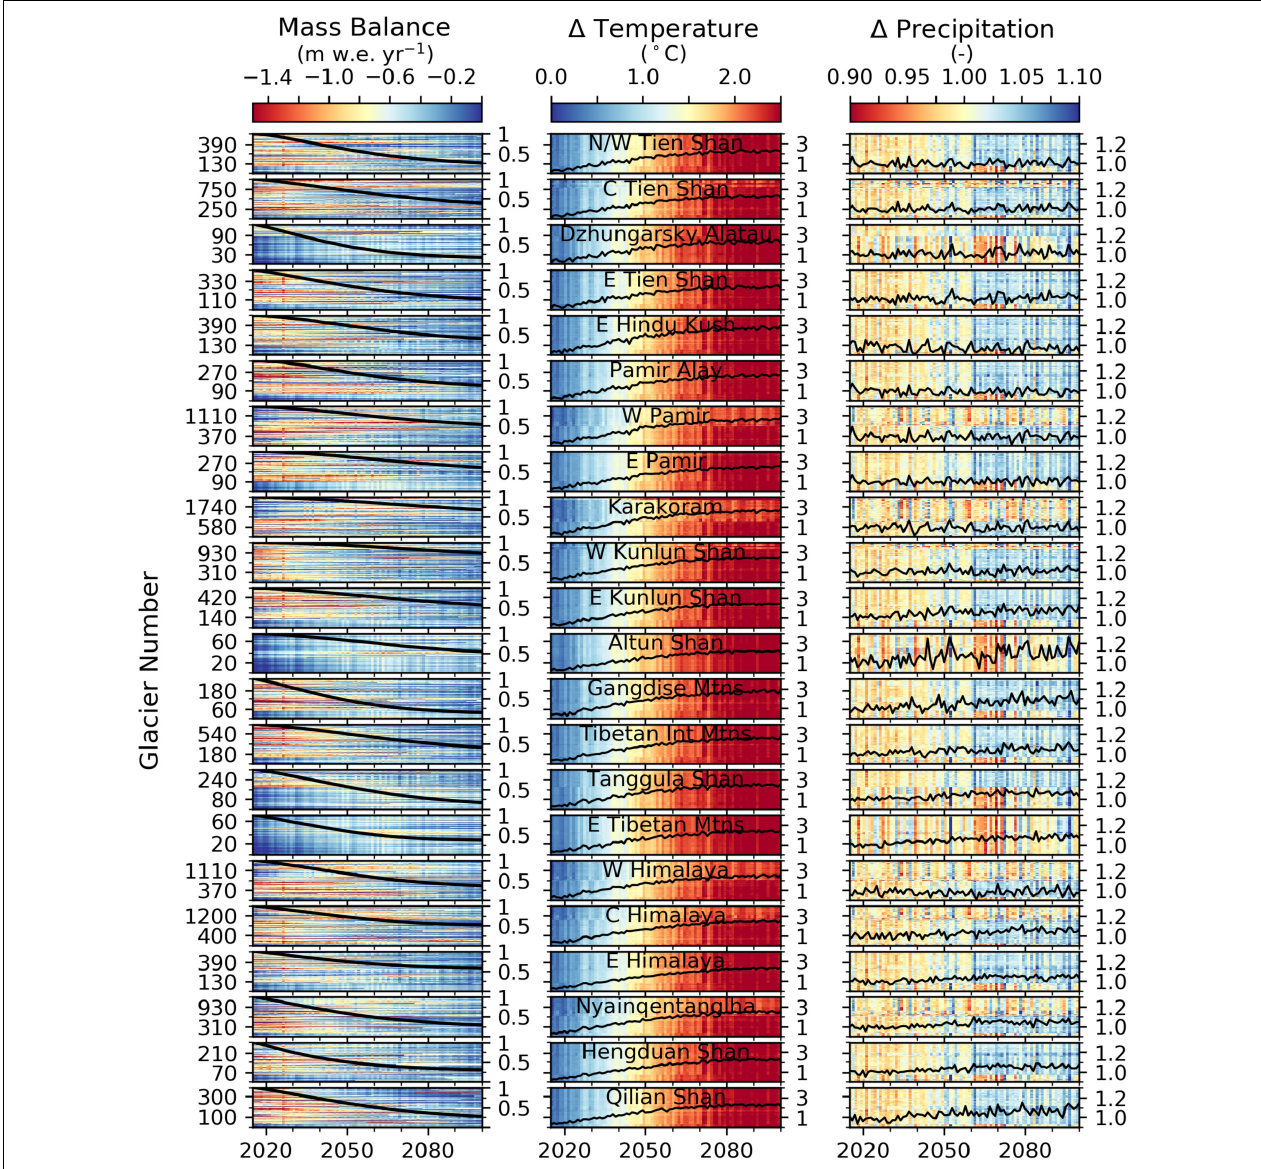
FIGURE 4 | Mass balance and bias adjusted temperature and precipitation changes relative to the mean from 2000 to 2015 for each glacier greater than 1 km 2 from 2015 to 2100 for RCP 4.5. Each row is a glacier and glacier number refers to the number greater than 1 km 2 in each region. Glaciers are ordered according to the RGIId in each subregion. Lines show the normalized regional mass remaining relative to 2015, and the area-weighted bias adjusted temperature and precipitation changes relative to the mean from 2000 to 2015. White color for the mass balance indicates the glacier has completely melted. Regions are from Bolch et al. (2019). C, Central; E, Eastern; N, Northern; W, Western; Int, Interior; Mtns, Mountains. RCP 2.6, RCP 6.0, and RCP 8.5 are shown in the Supplementary Figures S2–S4